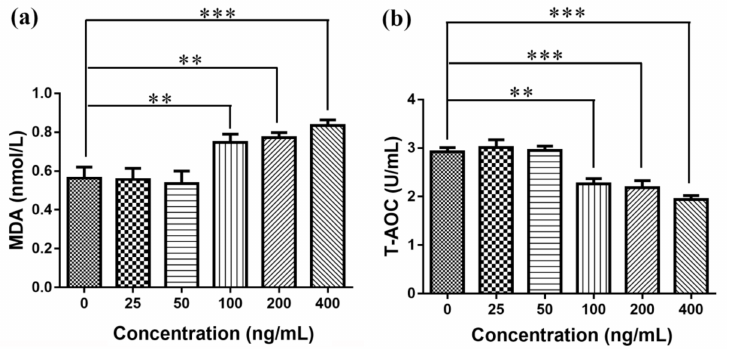
Figure 7. Elisa detection of malondialdehyde (MDA) production and total antioxidant capacity (T-AOC): ( a ) MDA generation and ( b ) T-AOC detection. ** p ≤ 0.01, *** p ≤ 0.001 versus control group, n =